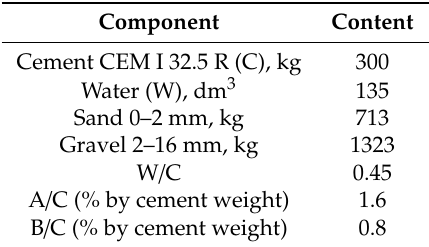
Table 1. The composition of the concrete mixture at a scale of 1 m 3 .